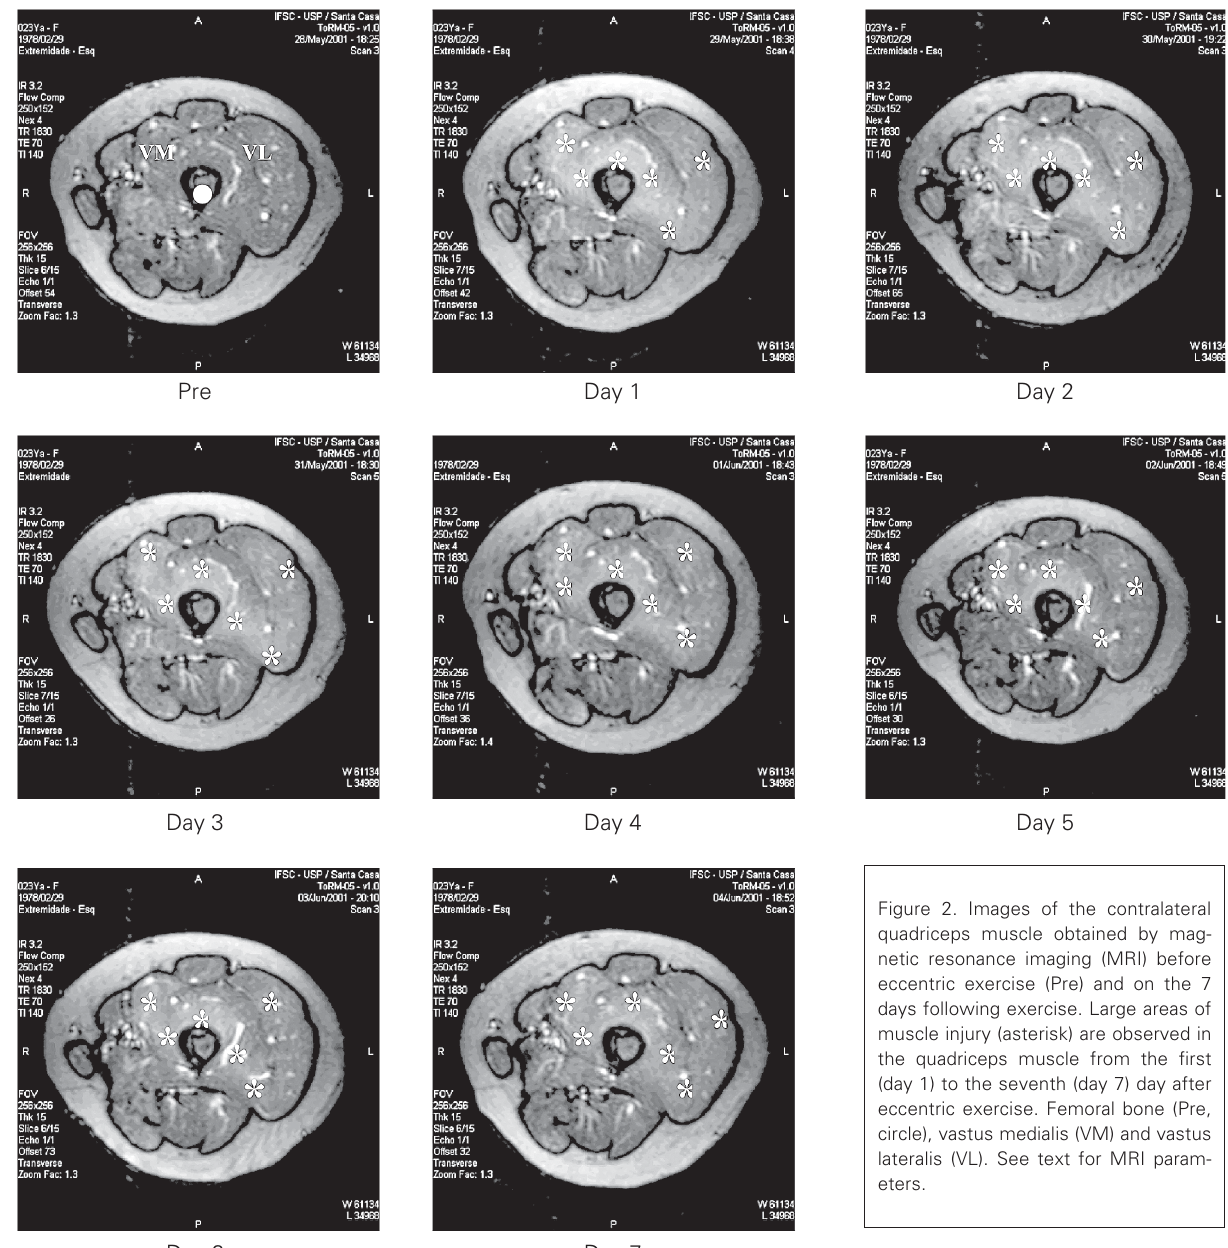
Figure 2. Images of the contralateral quadriceps muscle obtained by mag- netic resonance imaging (MRI) before eccentric exercise (Pre) and on the 7 days following exercise. Large areas of muscle injury (asterisk) are observed in the quadriceps muscle from the first (day 1) to the seventh (day 7) day after eccentric exercise. Femoral bone (Pre, circle), vastus medialis (VM) and vastus lateralis (VL). See text for MRI param-